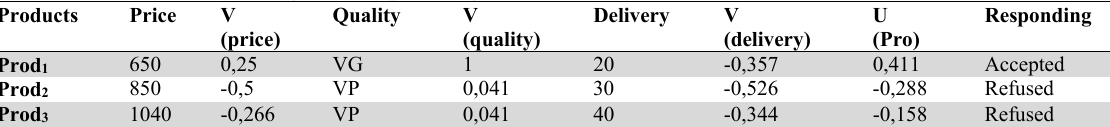
Round 1: CPNA Conceding and